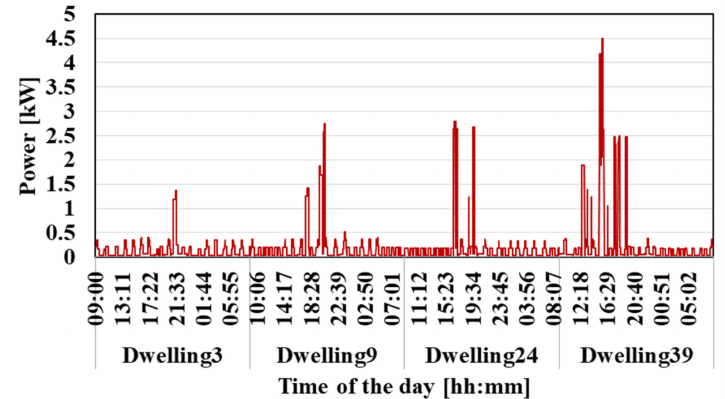
Figure 1. Inflexible load–demand of dwelling3, dwelling9, dwelling24 and